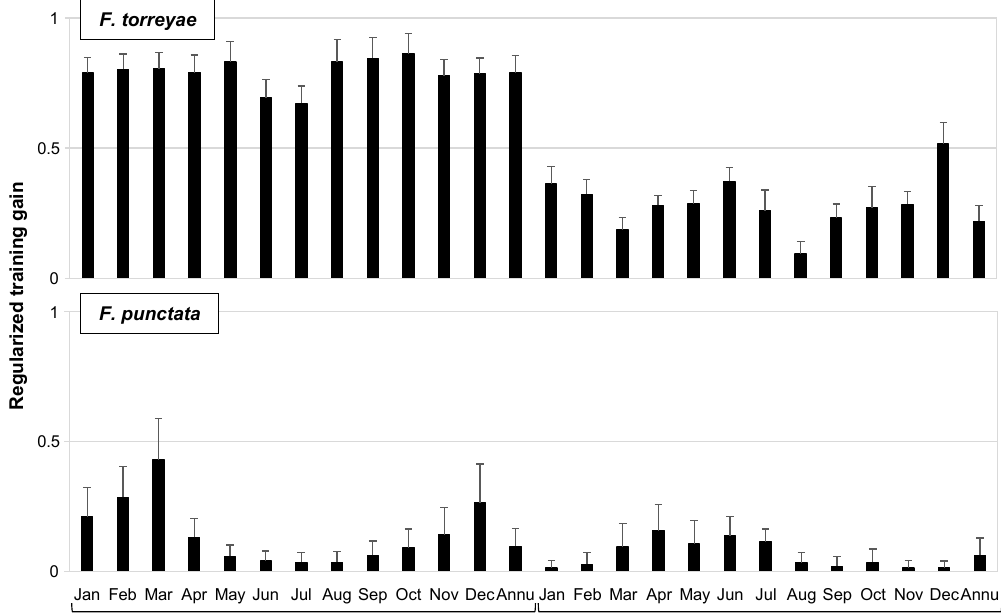
Figure 2. Regularized training gain in Maxent models with each environmental variable alone. The gains were calculated by jackknife analysis for variable importance. Values are the mean + standard deviation (100 bootstrap replicates). Monthly and annual average temperature and monthly and annual precipitation were used as variables for the Maxent analyses and are shown on the x -axis.